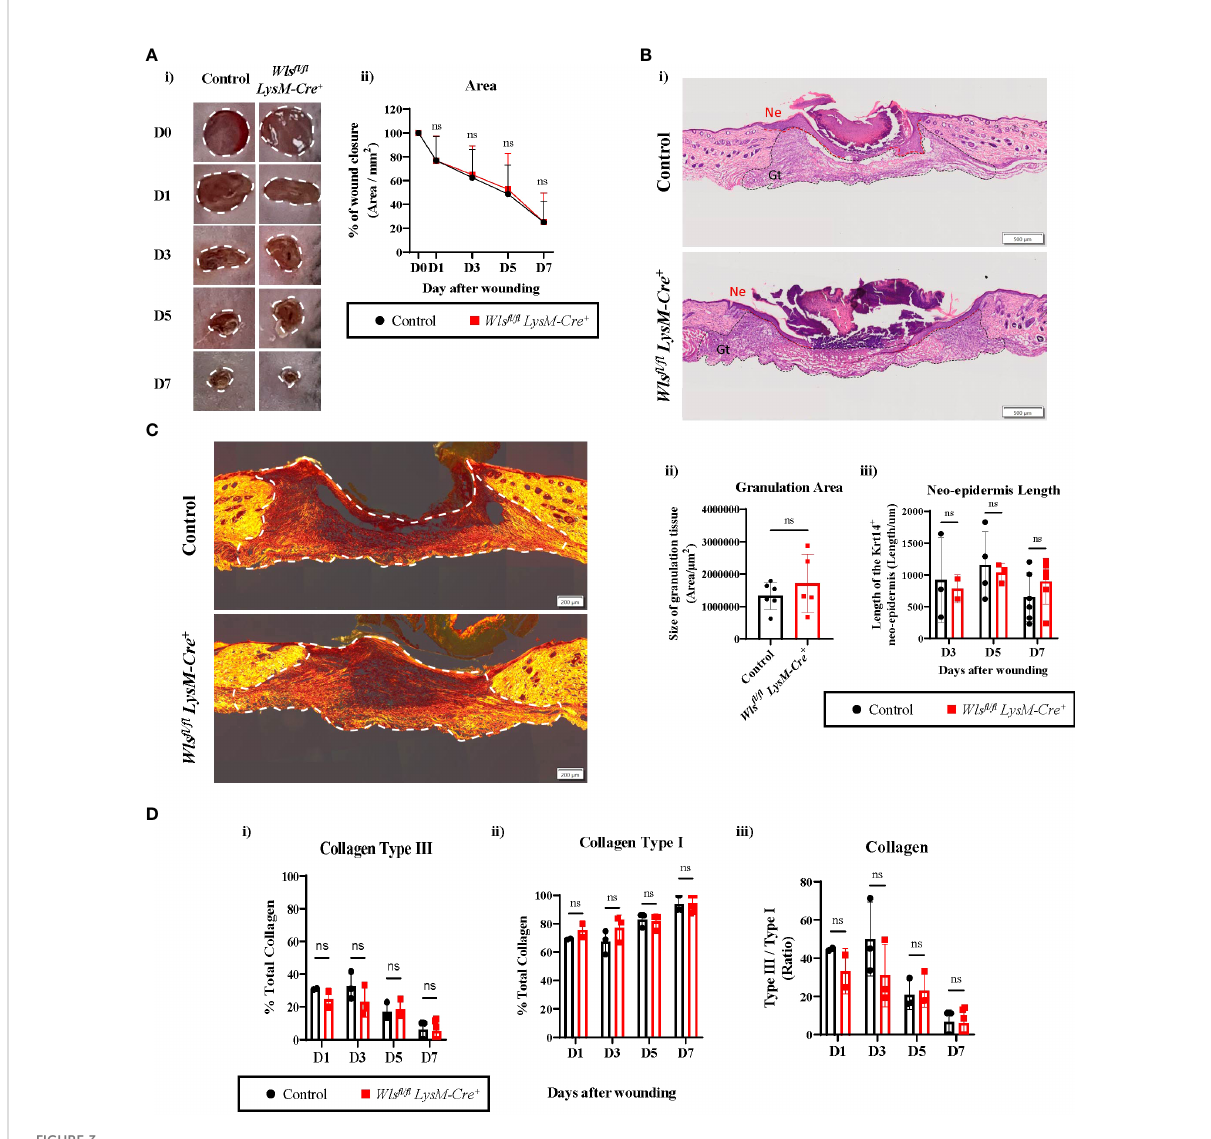
FIGURE 3 Wls de fi ciency in myeloid cells does not affect wound healing rate. (A)(i) Representative digital photography images showing wound closure of the Wls fl / fl LysM-Cre + and control mice during the seven days wound healing time course. White dotted line depicts area measured for wound closure. (ii) No signi fi cant difference was observed in wound closure rate between the Wls fl / fl LysM-Cre + and control animals at all time points (n = 4 – 23 biologically independent animals). (B)(i) Representative Hematoxylin and Eosin staining of skin wounds (scale bar = 500µm) demonstrating no histological difference for (ii) area of the granulation tissue (Gt) (n = 5-6 biologically independent animals) and (iii) length of the neo-epidermis (Ne) (n = 2-6 biologically independent animals) between the Wls fl / fl LysM-Cre + and control groups after wounding. (C) Representative picrosirius red staining images of day 7 wounds between control and Wls fl / fl LysM-Cre + animals (scale bar = 200µm). White dotted line highlights area used to measure for collagen deposition. (D) Collagen deposition analysis showed progressive reduction of (i) collagen type III to (ii) type I between day 1 and day 7. (iii) No change of collagen type III to type I ratio was observed between Wls fl / fl LysM-Cre + and control wound at all times (n = 2-6 biologically independent animals). Data are represented as mean ± SD. Statistical analysis was performed using unpaired Student t-tests. ns, not signi fi